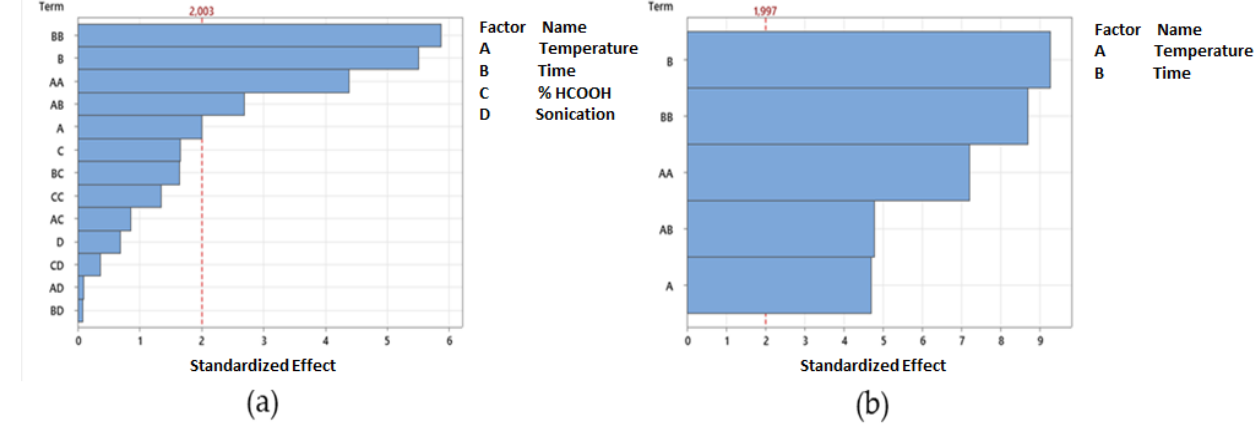
Figure 1. ( a ) Pareto chart of the total parameters analyzed (significative and not significative); and ( b ) Pareto chart of significative parameters only, i.e., temperature (A) and extraction time (B). Based on the statistical results of model fitting, the best model to optimize the phlorizin output would be by reducing the statistical analysis to two-factor interaction (2FI, i.e., A and B) (Figure 1). The multiple regression analysis of phlorizin values showed that the model was significant ( p < 0.0001), did not present a lack of fit (p = 0.182), and a percentage predictivity of the model was of 73.56% (R-sq 77.58%, R-sq(adj) 75.88%; R-sq(pre) 73.41%). Second-order quadratic polynomial models were found to be adequate to describe the effect of the two independent and significative factors on the phlorizin output, as described by Equation (1), in terms of uncoded